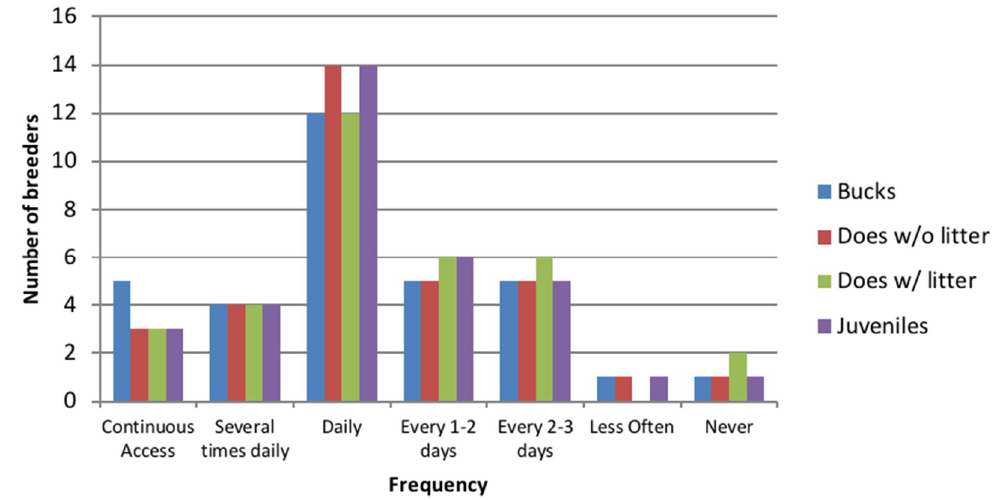
Figure 4. Access provided to runs by breeders for difference types of rabbit within the breeding colony.